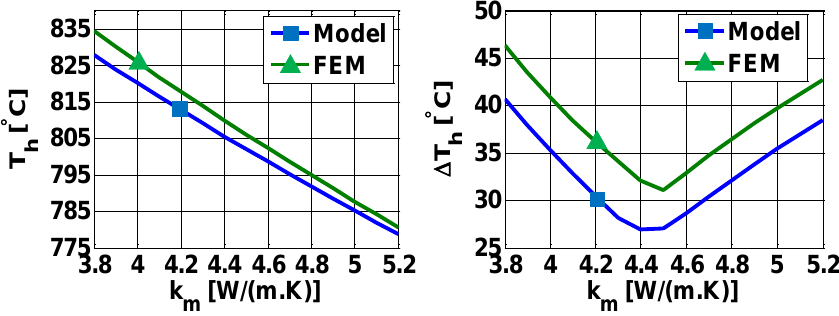
Figure 8. Influence of a spread in the thermal conductivity of the membrane, k average temperature, T the hot region.